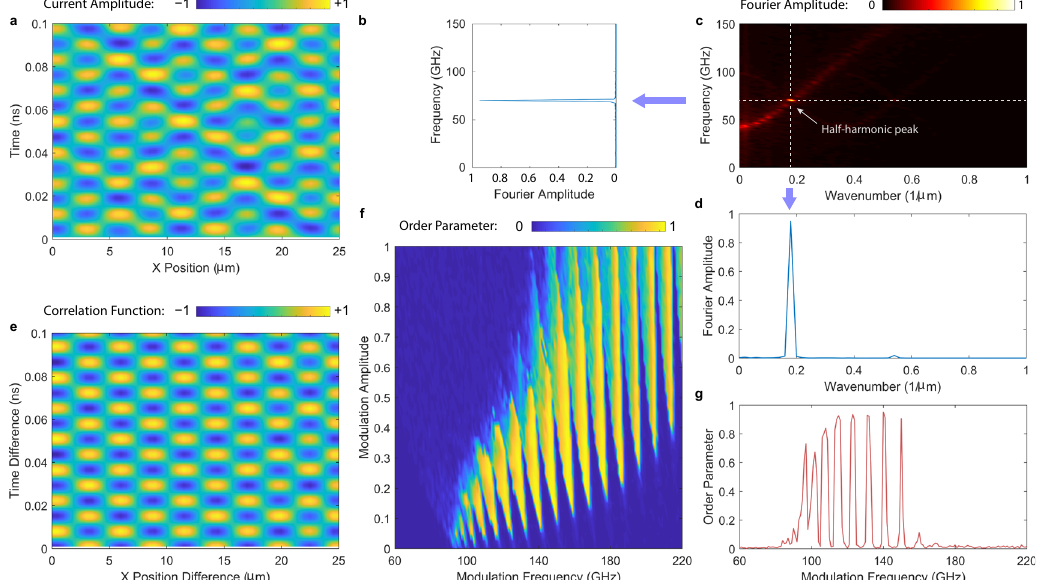
Fig. 3 Calculation on an effectively 1D single-layer long Josephson junction in BSCCO under parametric modulation at 4 K. The junction length is L = 25 μ m and width is W = 2 μ m. a Space − time trace of the current density j z ( t ) in the Floquet steady state under the modulation frequency f mod ¼ 140 GHz and modulation amplitude A mod ¼ 0 : 1. b Linescan along the frequency axis in ( c ) at the peak wavenumber, showing a peak frequency = 2 (cid:3) 70 GHz. c Fourier transform to j ∣ j β , f ) ∣ , where β is the wavenumber around the half-harmonic frequency f z ( x , t ) in ( a ), plotted in the magnitude z ( mod along x . The graph shows a strong half-harmonic peak in the wavenumber-frequency plane. d Linescan along the frequency axis in ( c ) at the peak frequency, showing a peak wavenumber corresponding to the mode index l = 9. e Space − time-averaged current − current correlation function g ( δ x , δ t ) for f mod ¼ 140 GHz and A mod ¼ 0 : 1, showing an ordered spatiotemporal pattern. f Phase diagram of the spatiotemporal order parameter Δ xt versus modulation frequency f and amplitude A (with fi xed f p , temperature T = 4K, and thermal noise). Clear phase boundaries can be identi fi ed. g mod mod Spatiotemporal order parameter Δ xt versus f mod when A mod ¼ 0 : 1, showing a broadened parametric excitation band (compared with the 0D case) spanning ¼ 0 : 1 the correction factor C = 100 − 160 GHz, a range much higher than 2 f p = 94 GHz. For A mod